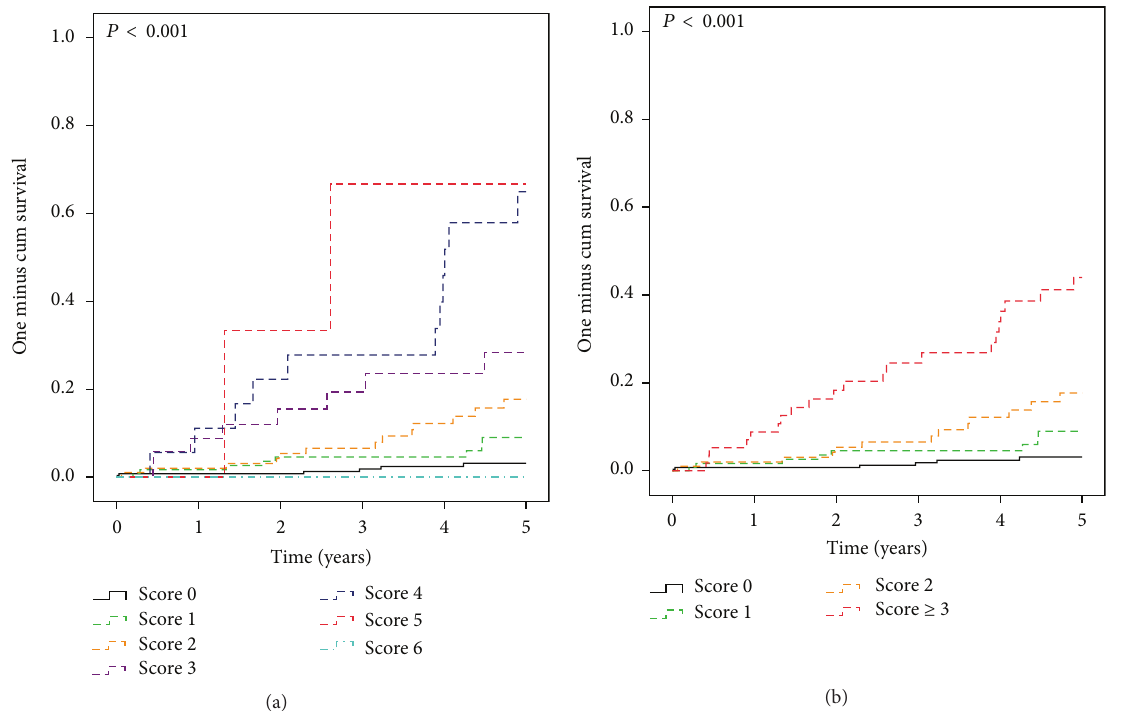
Table 3: Hazard ratios of individual CHADS